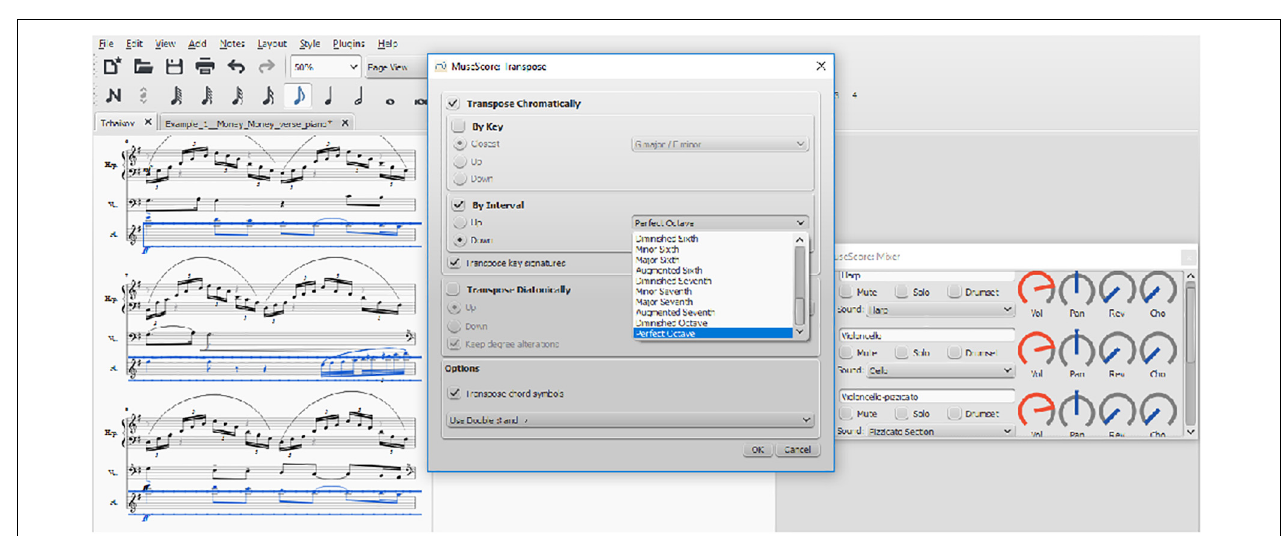
FIGURE 13 | The Transpose and Mixer